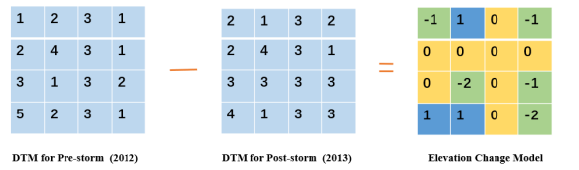
Figure 4. Schematic diagram of deriving Elevation change model